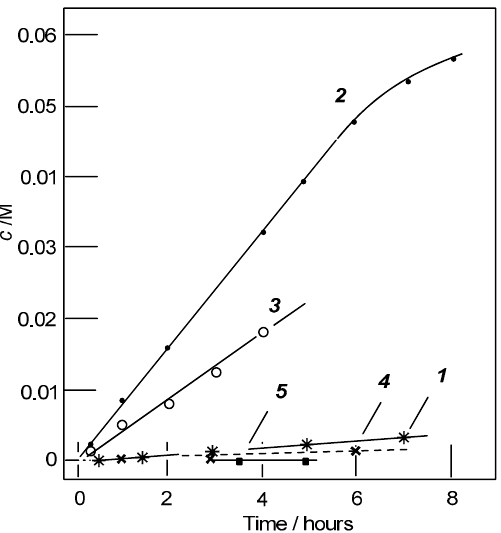
Figure 2. Accumulation of sum of oxygenates (predominantly cyclohexyl hydroperoxide) in the reaction of cyclohexane with hydrogen peroxide (in acetonitrile at 25 °C catalysed by complex 2 in the absence of additives (curve 1 ) and in the presence of aminoacids: PCA ( 2 ), pyrazine-2,3-dicarboxylic acid ( 3 ), picolinic acid ( 4 ), and pyridine-2,6-dicarboxylic acid ( 5 ). Adapted from [20] Copyright (2002), with permission of Elsevier.